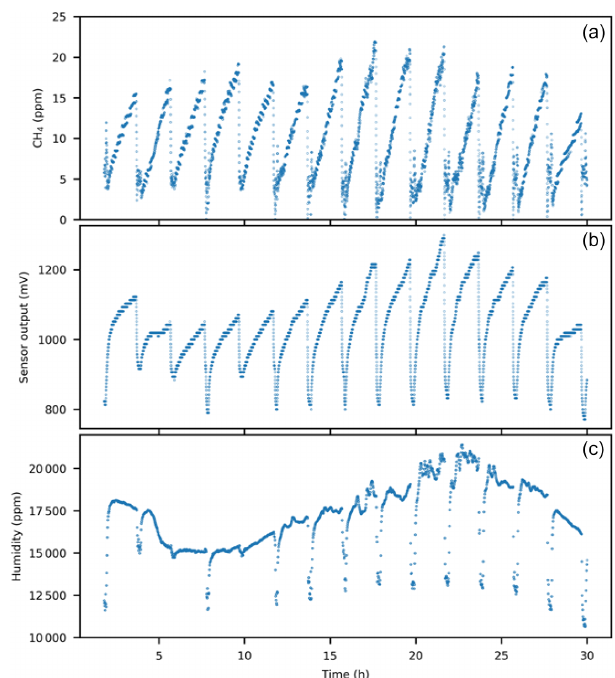
Figure 3. Real data from a flux chamber on a lake in June 2019 with 14 automated chamber open–closure cycles over 30h. Each cycle included a closed phase during which CH 4 increased in the chamber over time, followed by opening the chamber for flushing to background levels before starting the next cycle by closing the chamber. Panels show (a) calibrated CH 4 mole fractions based on this study, (b) untreated sensor output signal, and (c) absolute hu-